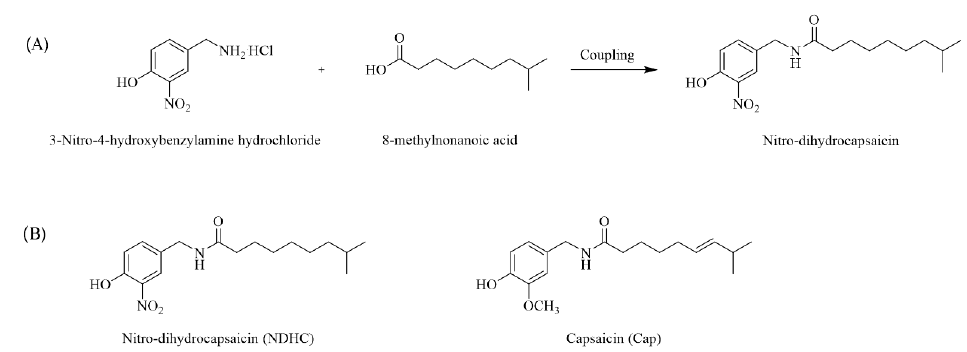
Figure 1. Schematic structure of nitro dihydrocapsaicin (NDHC). ( A ) Synthetic route of preparation of capsaicinoid analogs, NDHC. ( B ) Chemical structures of NDHC and capsaicin (Cap).